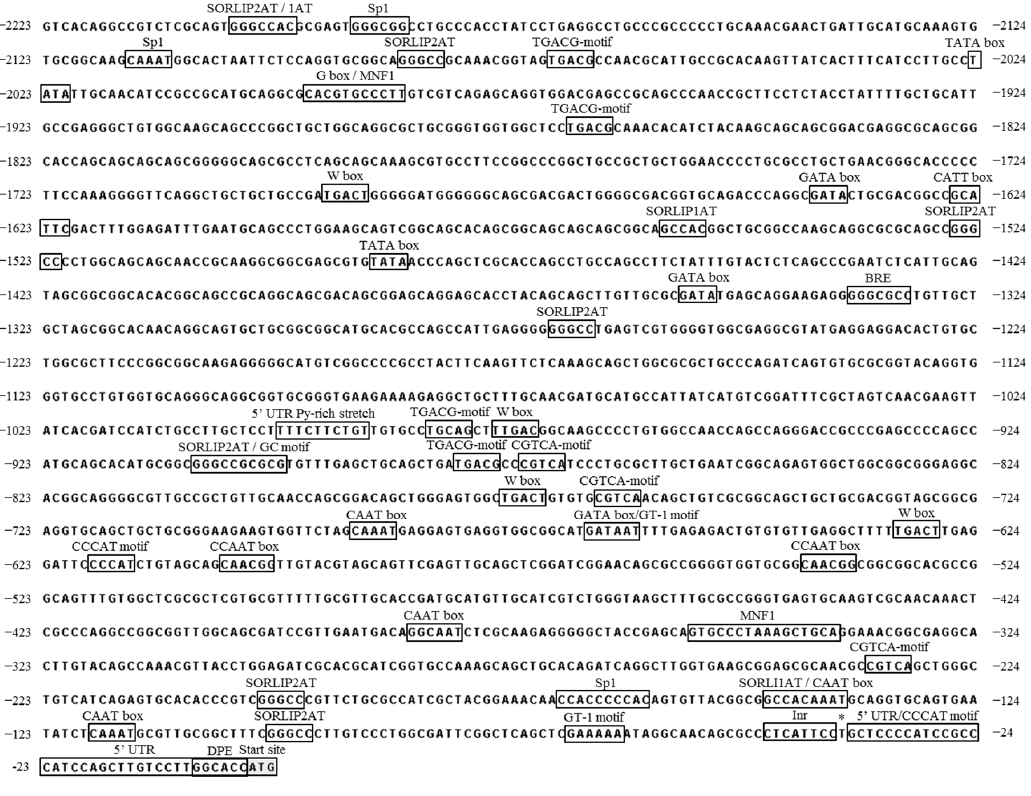
Figure 2. Nucleotide sequence of the CvpsaD promoter and its predicted motifs. The start codon (ATG) is highlighted in a gray box and the putative transcriptional start site (TSS) is indicated by an asterisk. The putative cis-acting elements are boxed and labeled. Table 1. List of putative cis-acting elements in the psaD promoter in Chlorella vulgaris .